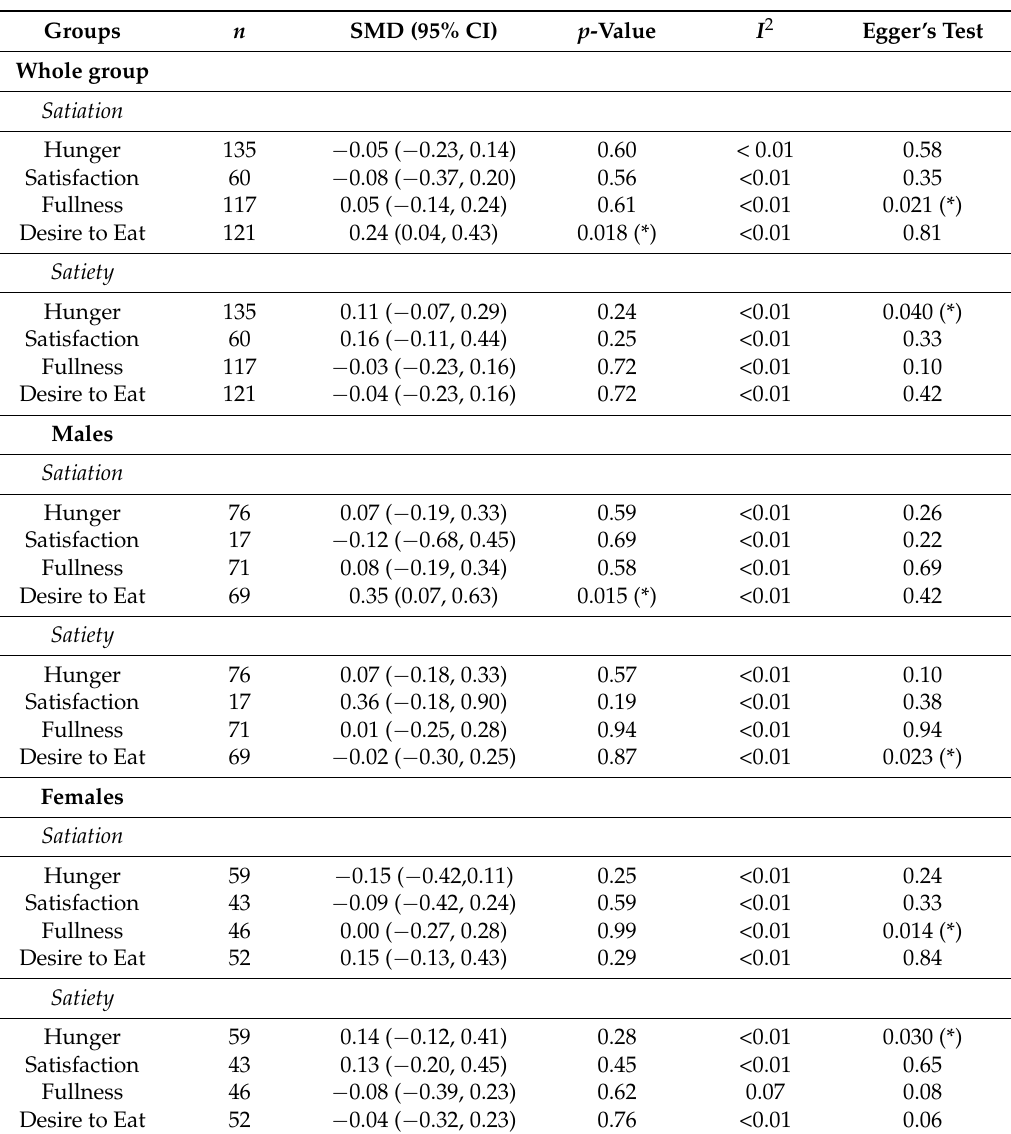
Table 3. Meta-analysis, by sex, of subjective feelings of appetite for the Satiation and Satiety periods of the polydextrose studies selected for this